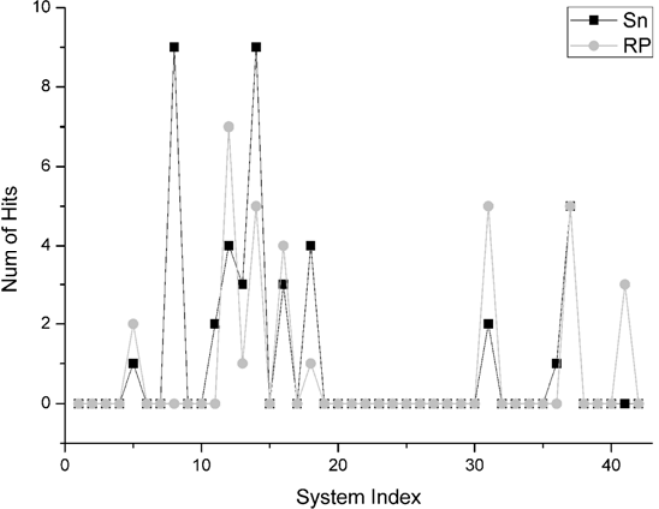
Figure 6. For the unbound dock results, the comparison of the numbers of the hit structures of the Sn and RP score